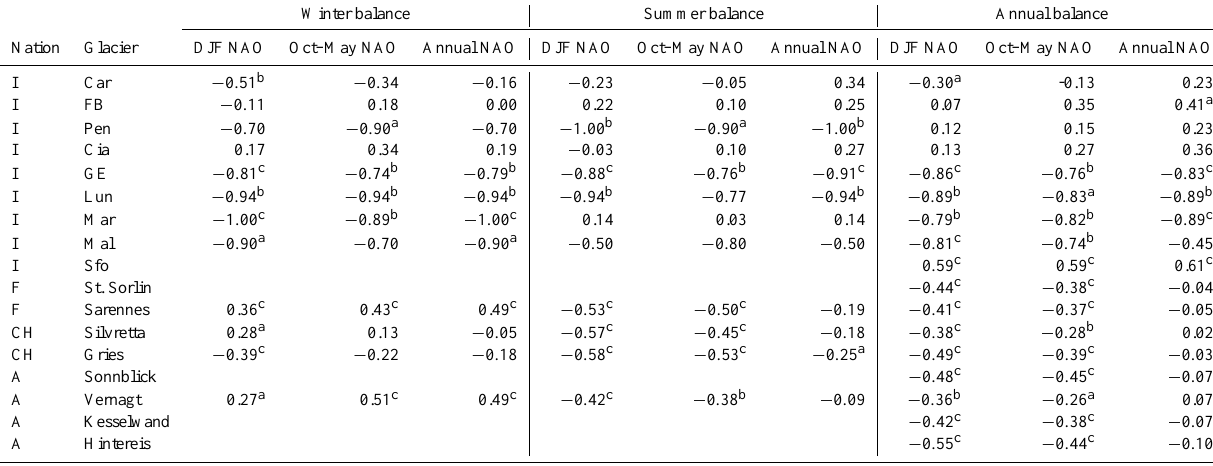
Table 5. Correlation coefficients of B w , B s and B a versus seasonal and annual NAO. Five-year triangular moving averages have been applied to the time series before correlation analyses.